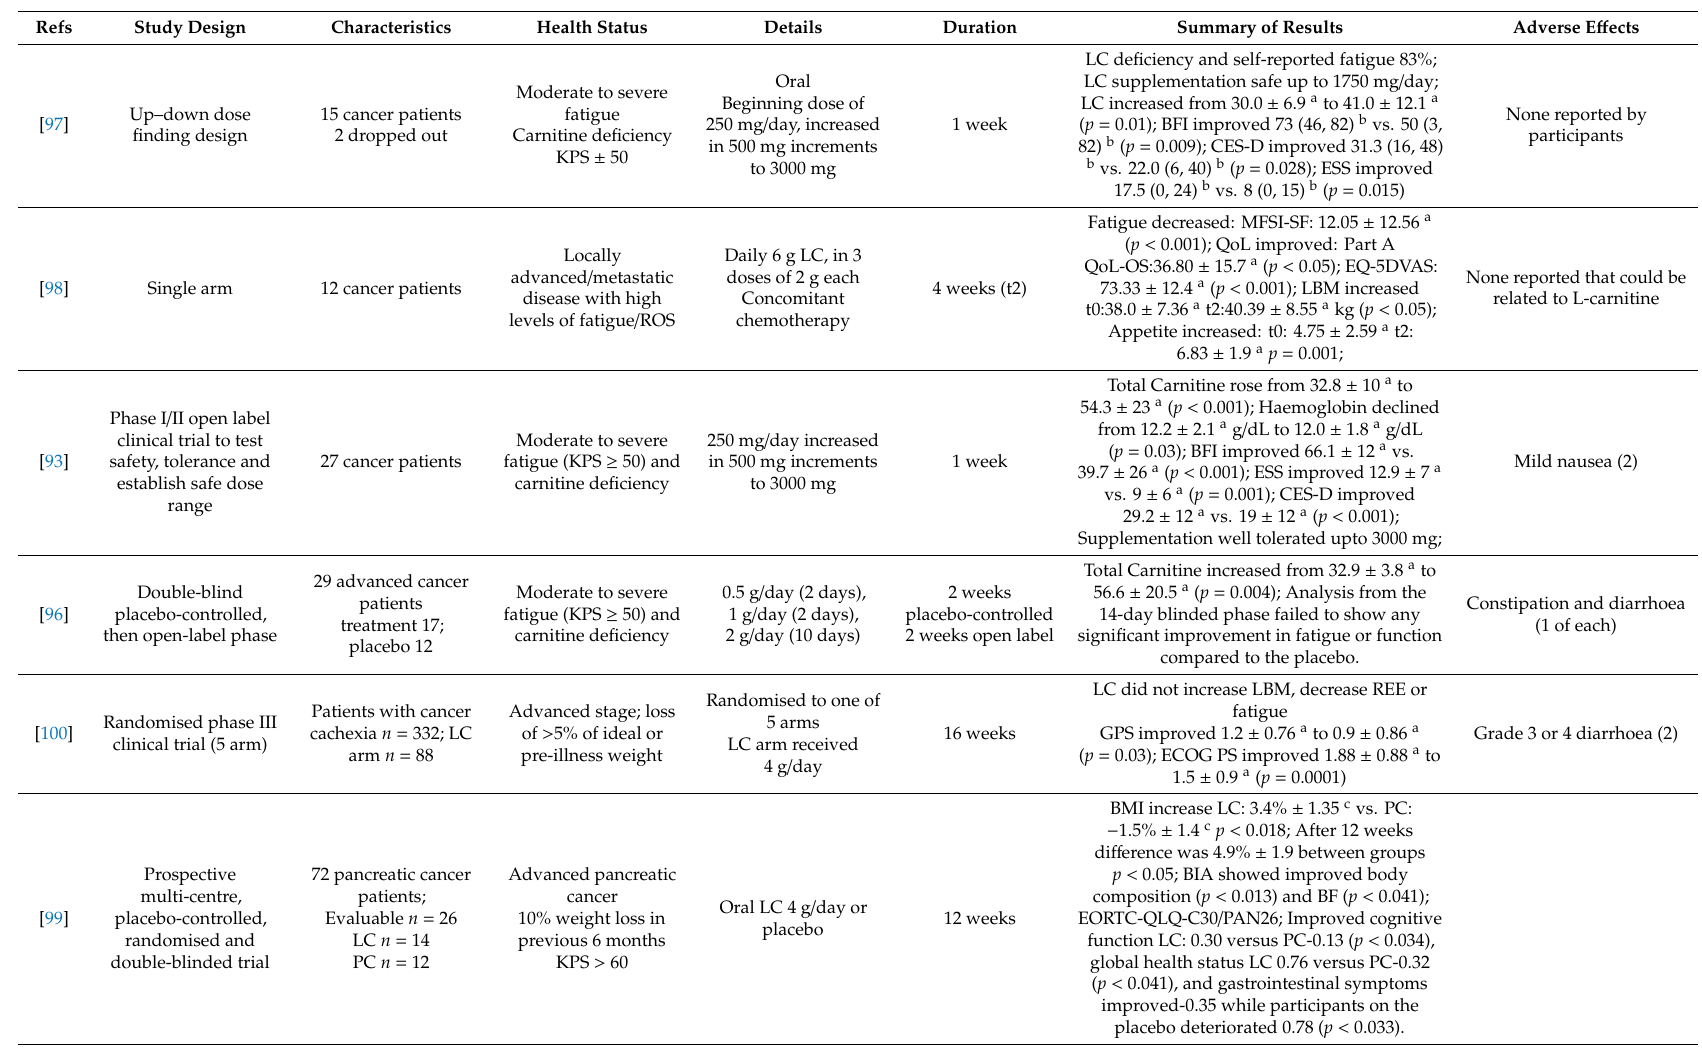
Table 3. Summary of L-carnitine intervention studies carried out on cancer